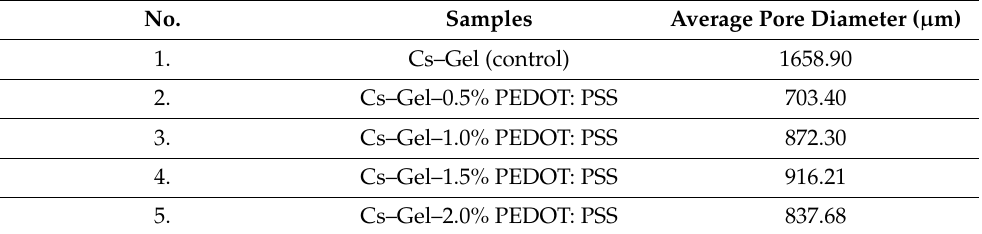
Table 2. List of samples with their respective average pore